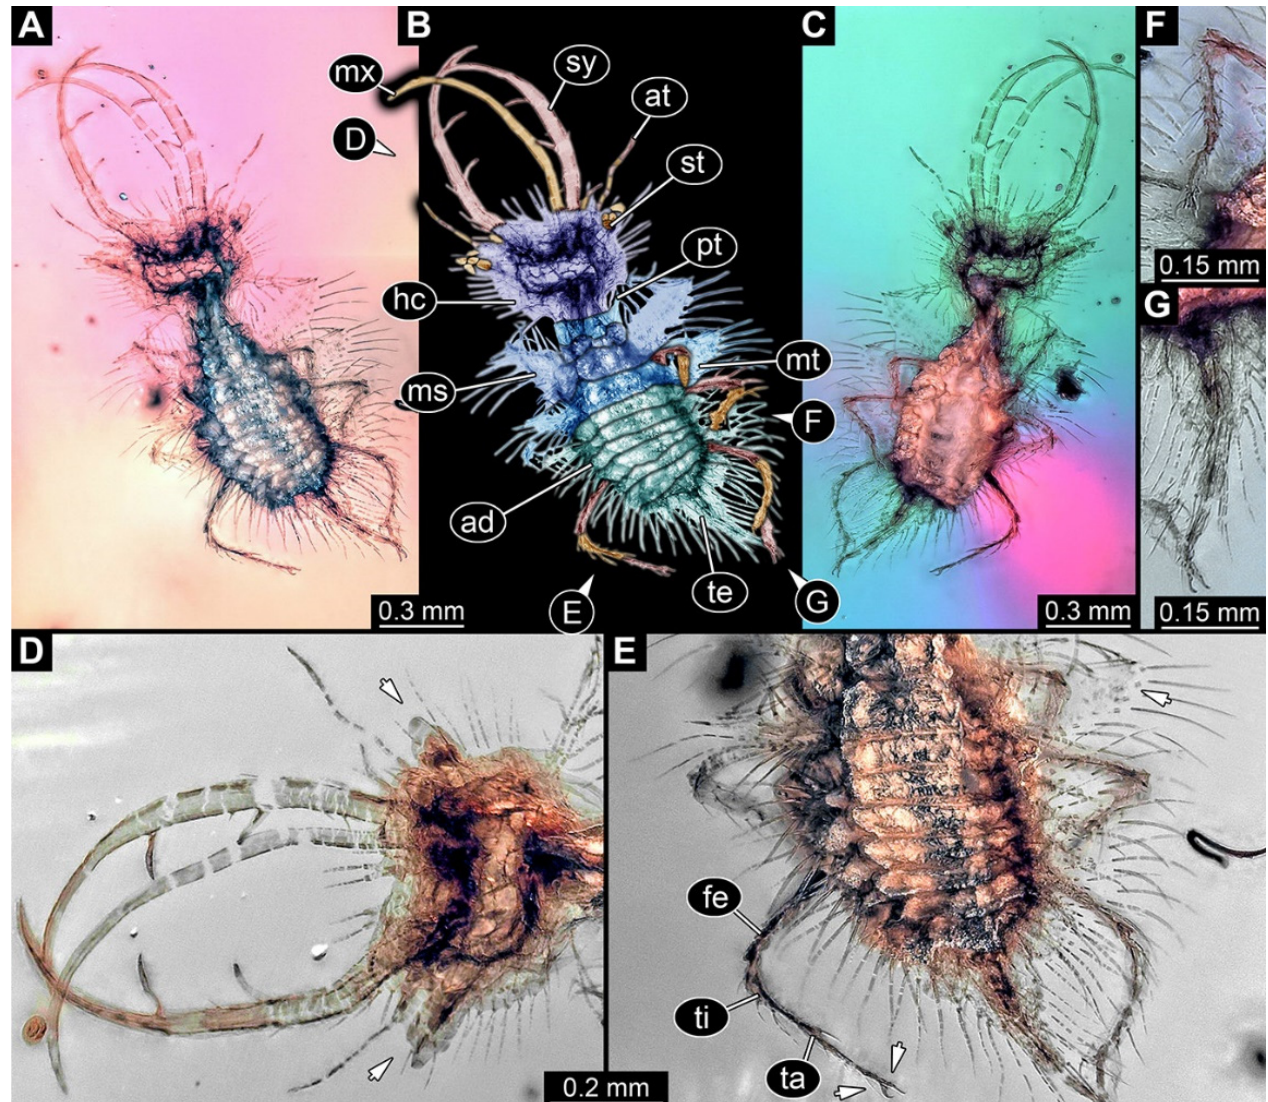
Figure 32. Fossil owllion larva, specimen 3245 (PED 0944), Cretaceous Kachin amber, Myanmar. ( A ) Overview, dorsal. ( B ) Color-marked version of ( A ). ( C ) Overview, ventral. ( D ) Close-up on head capsule with fields of stemmata (arrows). ( E ) Close-up on trunk with locomotory appendages with claws (left arrows) and dorsal process (right arrow). ( F , G ) Close-ups on locomotory appendages. Abbreviations: ad = abdomen; at = antenna; fe = femur; hc = head capsule; ms = mesothorax; mt = metathorax; mx = maxilla; pt = prothorax; st = stemmata; sy = stylet; ta = tarsus; te = trunk end; ti = tibia.